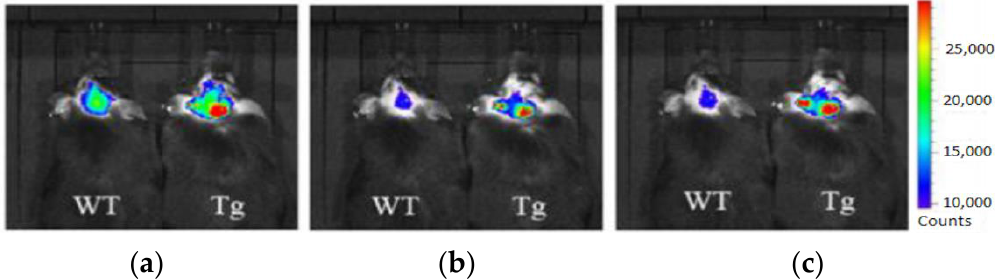
Figure 8. In vivo imaging of Aβ using QAD-1 in APPSWE/PSEN 1dE9 transgenic (Tg) and wild-type (WT) mice [90]. From left to right, images were taken 5 ( a ), 15 ( b ), and 30 ( c ) minutes after QAD-1 injection. The significant difference between the QAD-1 uptake in transgenic and wild-type mice was observed 5 min post-QAD-1 injection. The hot-spots on the images correspond to the Aβ plaques localized in the APPSWE/PSEN 1dE9 transgenic mouse. The low background signal of QAD-1 can be observed in ( c ). Images are reprinted with permission of the publisher [90].